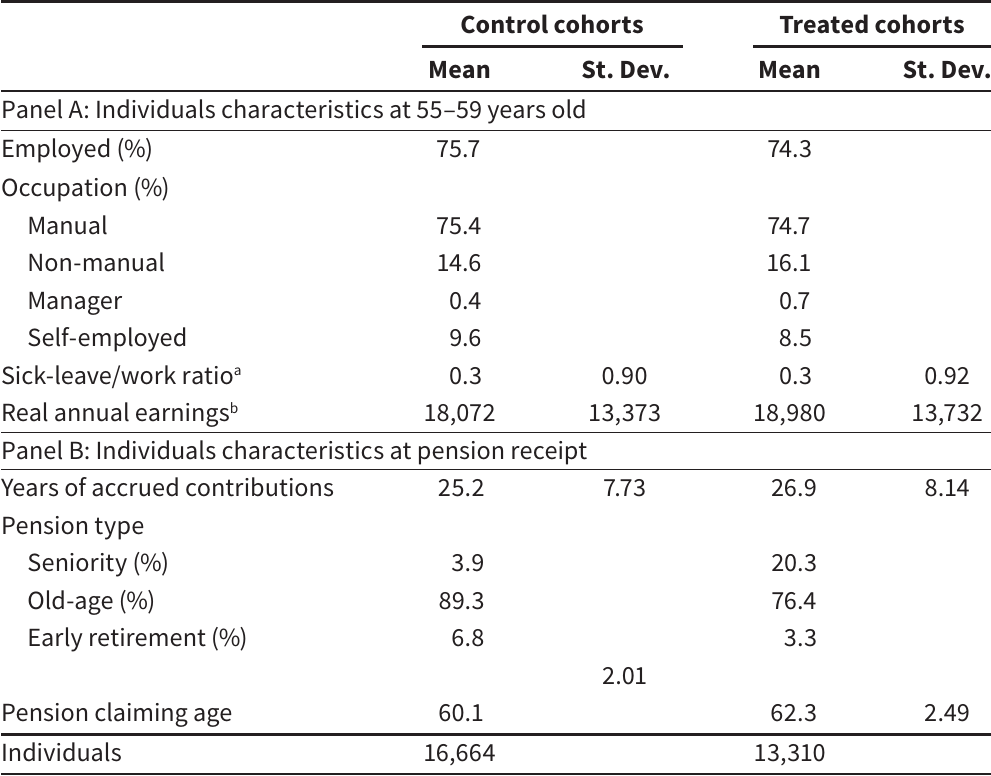
Table 2 Sample description